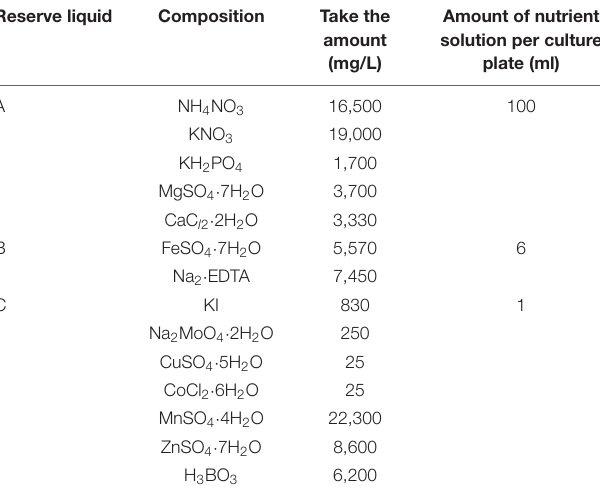
TABLE 3 | Preparation of rooting nutrient solution.